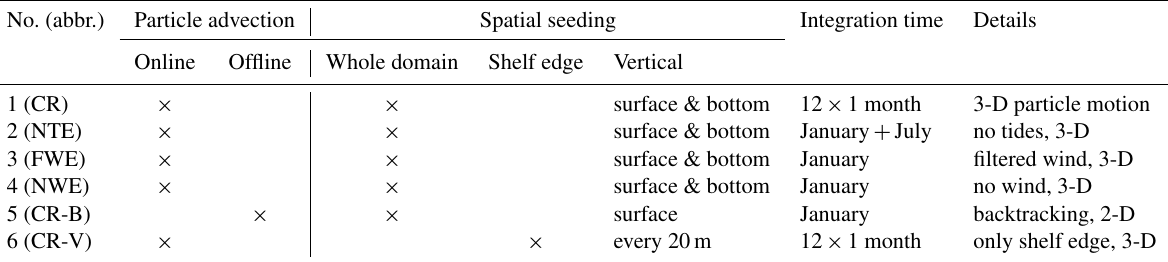
Table 1. Summary of the particle release experiments; further details are given in Sect. 2.3. Surface release is done at 1m depth and bottom release one grid cell above the sea floor. Particle release was done once at the beginning of the respective month in 2015. No. (abbr.) Particle advection Spatial seeding Integration time Details Online Offline Whole domain